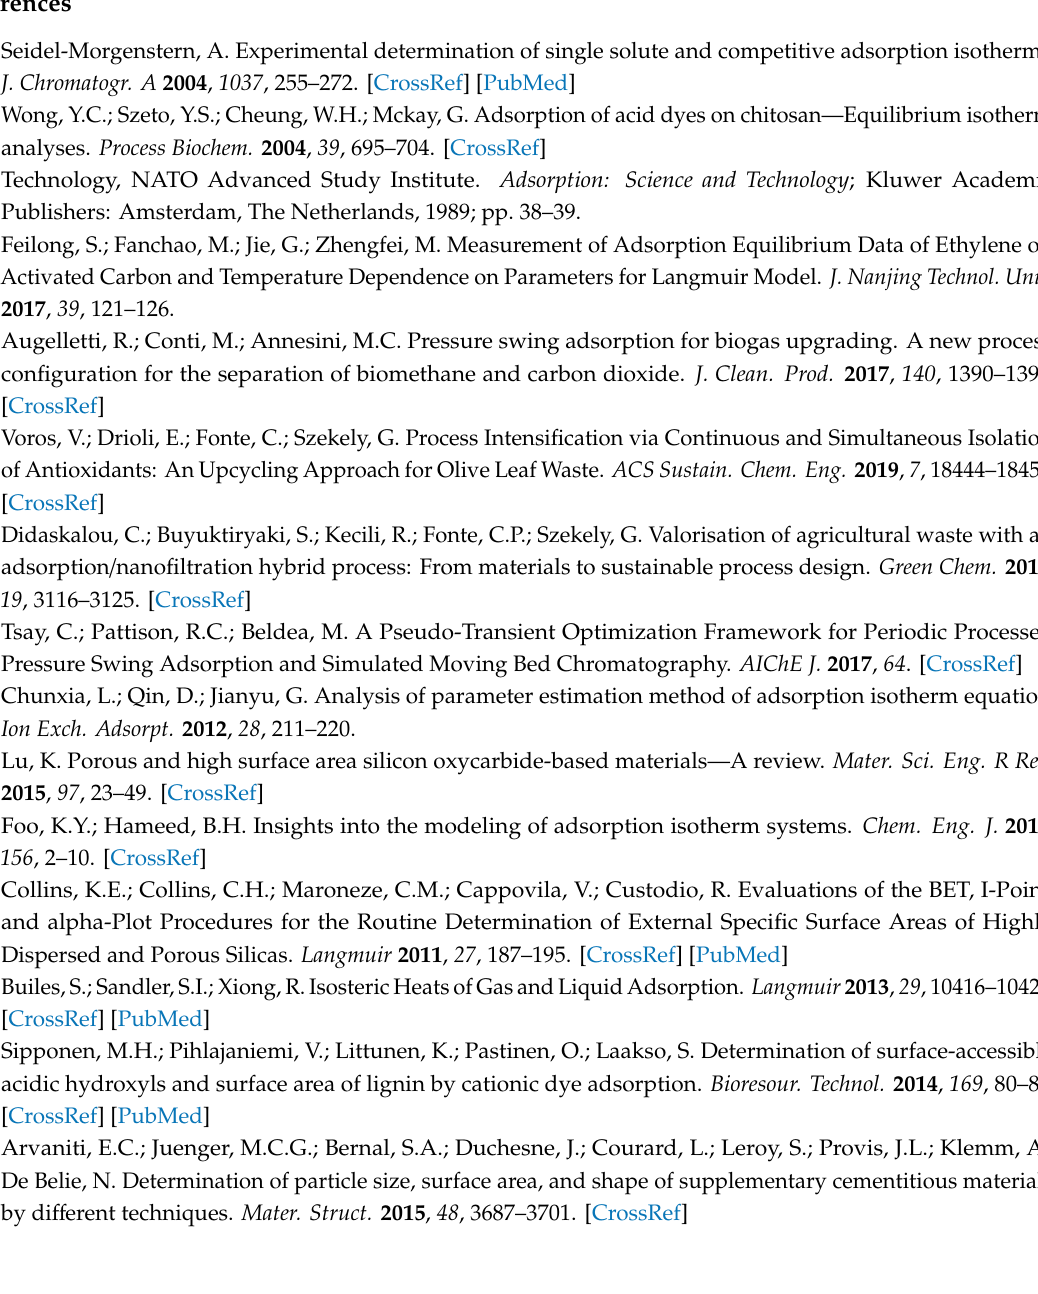
Figure S1: Comparison curves of the DSL model and the M-DSL model for di ff erent systems, Figure S2: Comparison curves of the TDSL model and the M-TDSL model for di ff erent